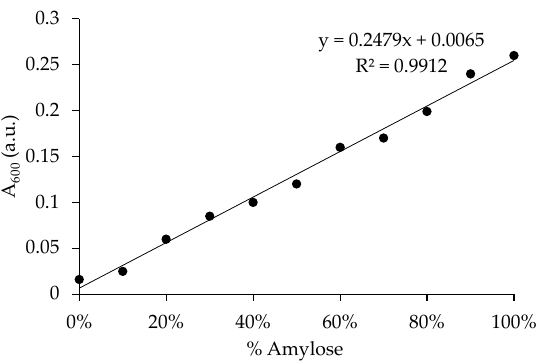
Figure 1. Calibration curve obtained from measurements of absorbance at 600 nm against percentage amylose (w/w) for samples prepared with different contents of pure amylose and amylopectin. Table 1. Real amylose content of commercially available starches from Ingredion.